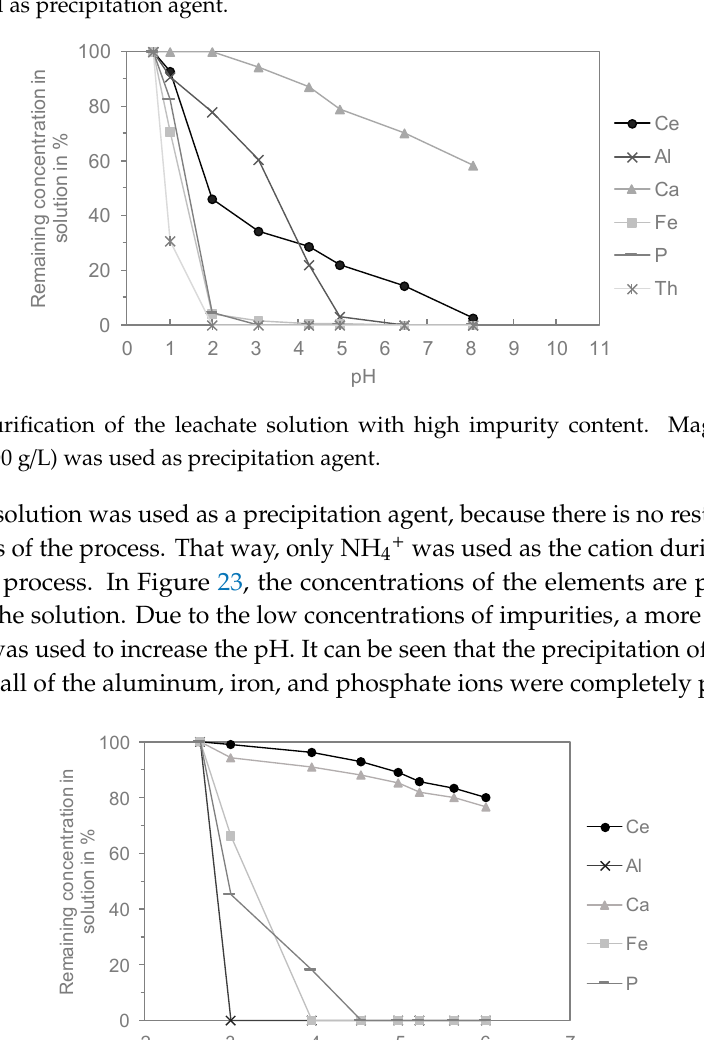
Figure 23. Purification of the leachate solution with low impurity content. An ammonium solution (3 wt%) was used as the precipitation agent.